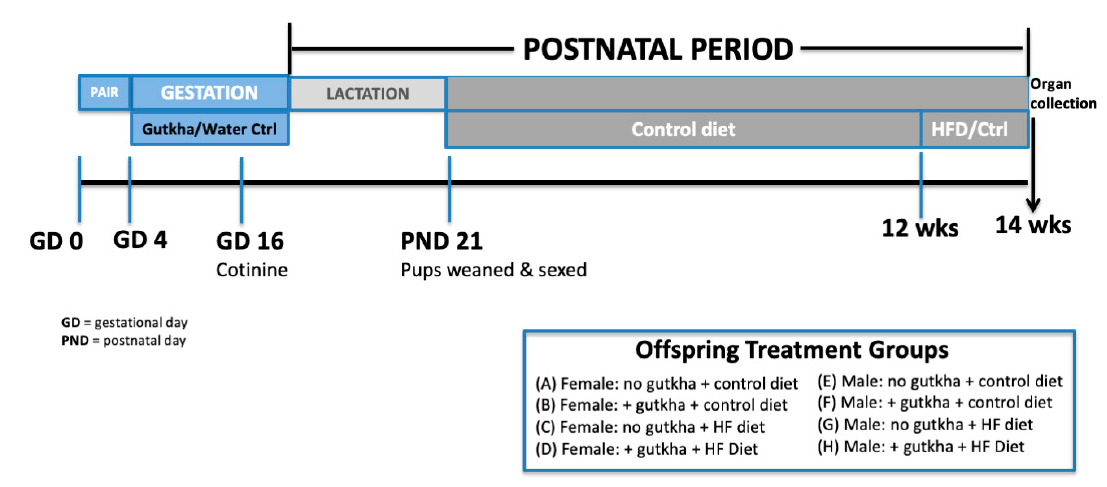
Figure 1. Experimental design and exposure timeline. GD = gestational day, PND = post-natal day. commercially available gutkha (RMD, India: